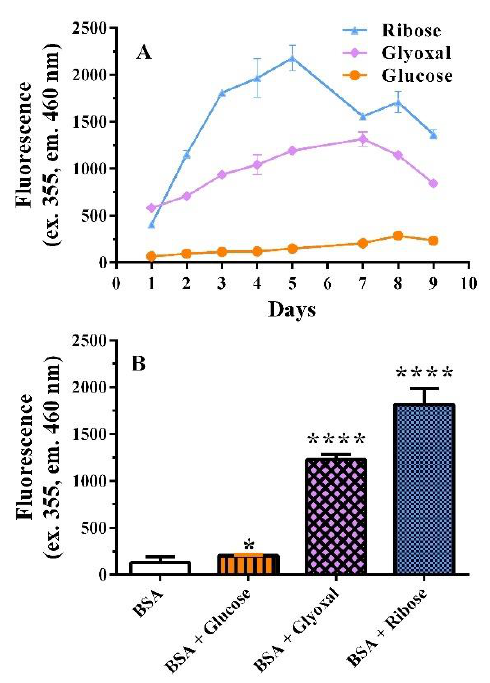
Figure 2. ( A ) Time course of AGE fluorescence during incubation of 50 mg/mL BSA with 0.1 M ribose, 0.003 M glyoxal and 0.8 M glucose. ( B ) Maximal AGE formation after 5 (ribose) and 7 days of incubation with the selected glycation agent. Data are the mean ± SEM of 3 – 6 experiments. * p < 0.05 and **** p < 0.0001 versus BSA (control). Turkey’s analysis test shows significant differences between BSA+glucose versus BSA+glyoxal or BSA+ribose ( p < 0.0001), or BSA+glyoxal versus BSA+Ribose ( p < 0.01).